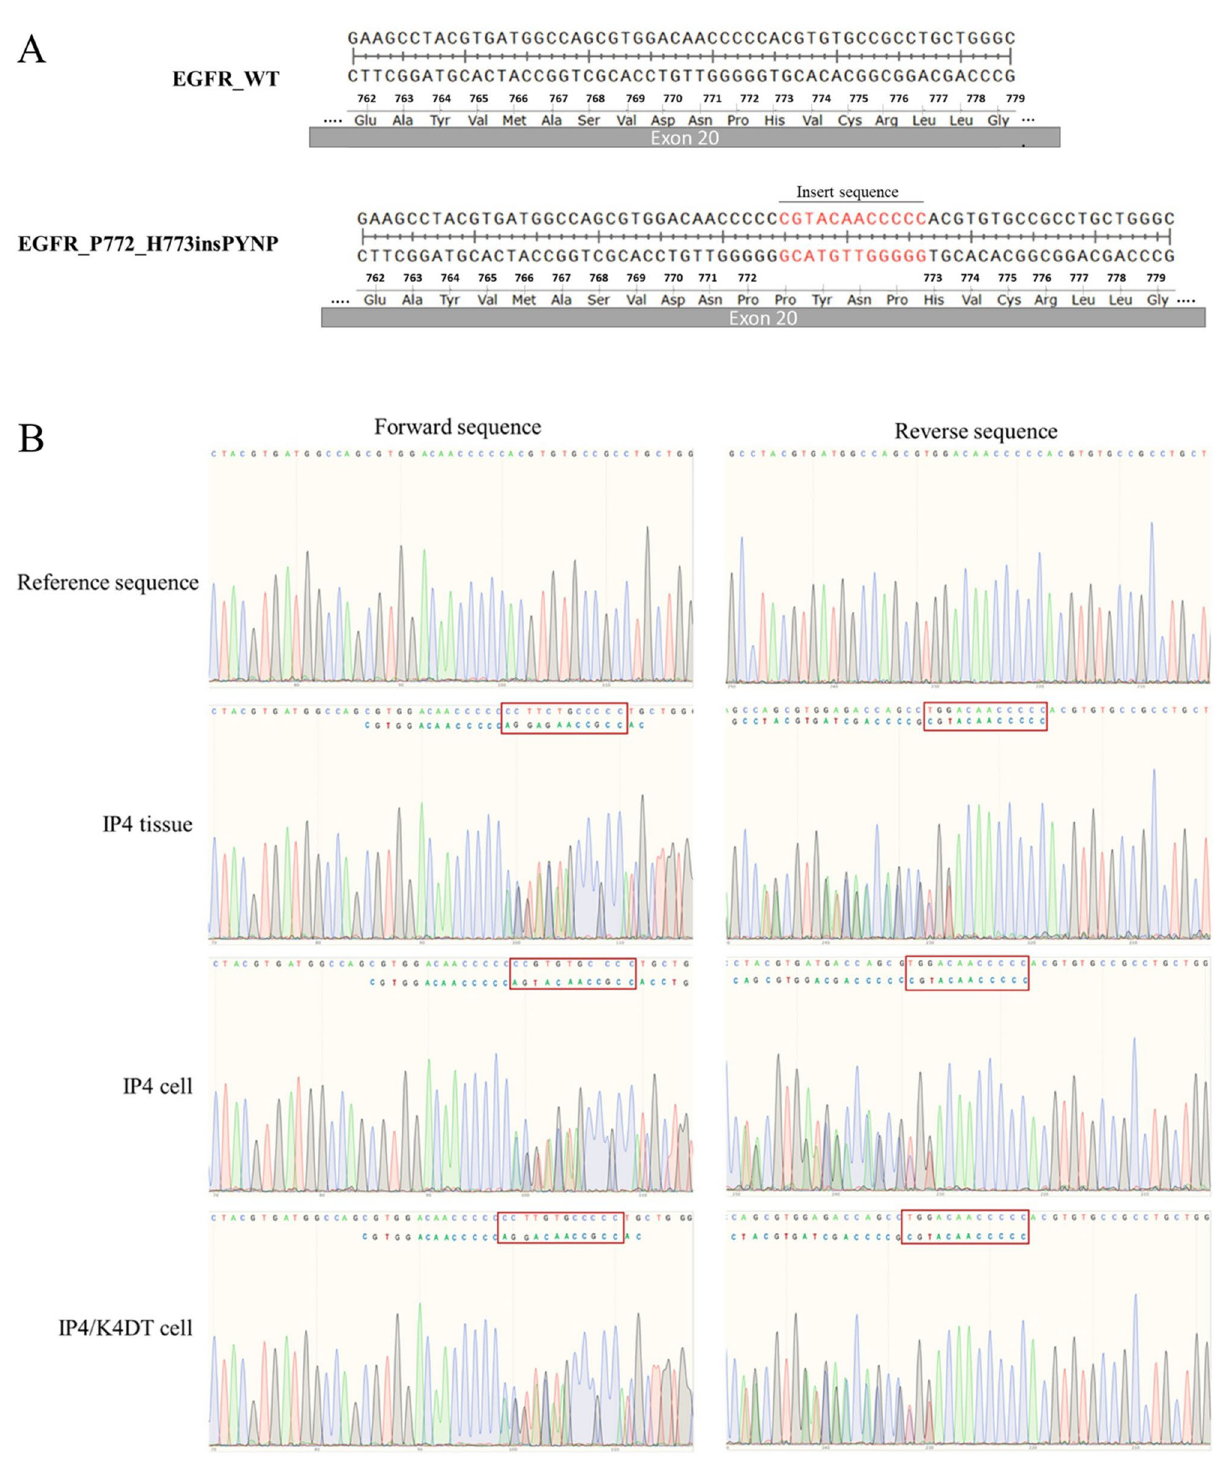
Figure 5. EGFR exon 20 insertion mutation in IP4 tissue and its derivatives. Mutation of EGFR exon 20 was analyzed by direct sequencing as described in Methods. ( A ) Schematic of wildtype- (Top) and IP4-derived EGFR exon 20 nucleotide and the corresponding amino acid sequences (Bottom). ( B ) EGFR exon 20 sequence electropherograms of IP4 tissue and its derivatives. The electropherograms were analyzed by CRISP-ID and the Mixed Sequence Reader. Both analyses identified the same heterozygous insertion mutation of EGFR exon 20 as indicated in ( A ) in both cell lines as in the primary